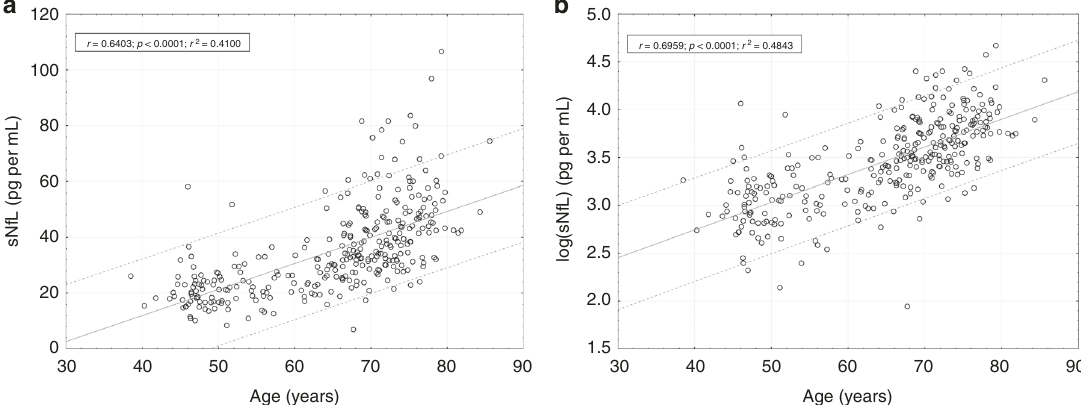
Fig. 2 Correlation of sNfL with age. Scatterplot of sNfL over age ( a ) and logarithmic transformed sNfL values ( b ). The dashed lines represent the 90% prediction interval, the continuous line denotes the regression line. ( r = Pearson regression coef fi cient, p = two-sided p value). Source data are provided as a Source Data fi